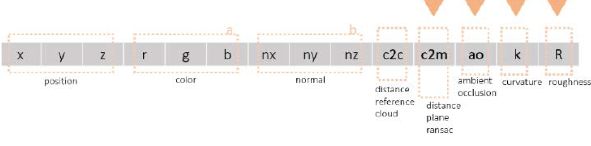
Figure 16. The result of the data mining: the new geometric